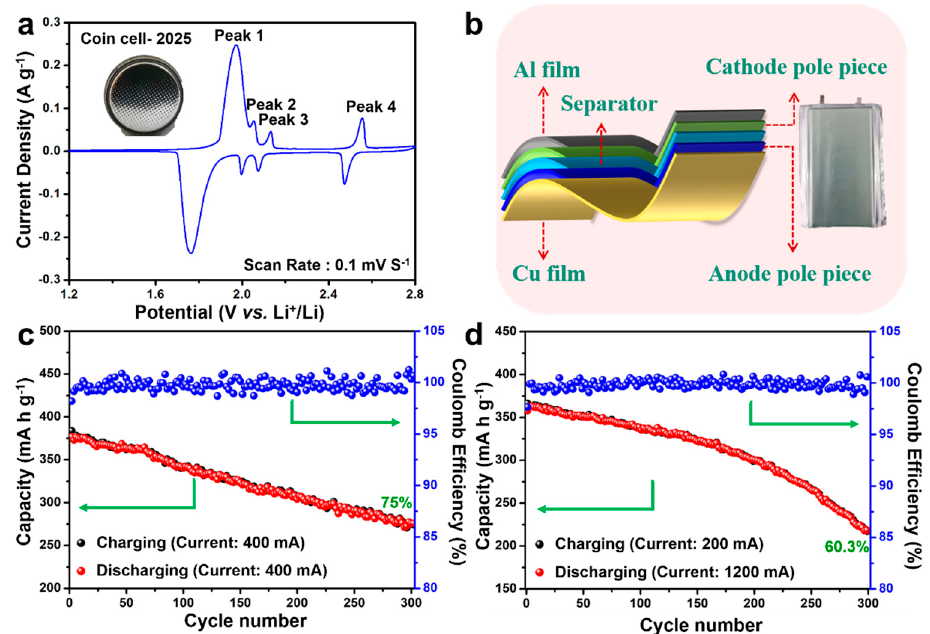
Figure 5. ( a ) CV curves of the 5LFVP||LTO Li-ion full cell measured in the potential range of 1.2–2.8 V; ( b ) schematic of 5LFVP||LTO Li-ion pouch cells; ( c ) cycling performance of 5LFVP||LTO Li-ion pouch cells at the constant current of 400 mA with the capacity retention ( d ) cycling performance of 5LFVP||LTO Li-ion pouch cells under the test conditions of charging at 200 mA and discharging at 1200 mA with the capacity retention.